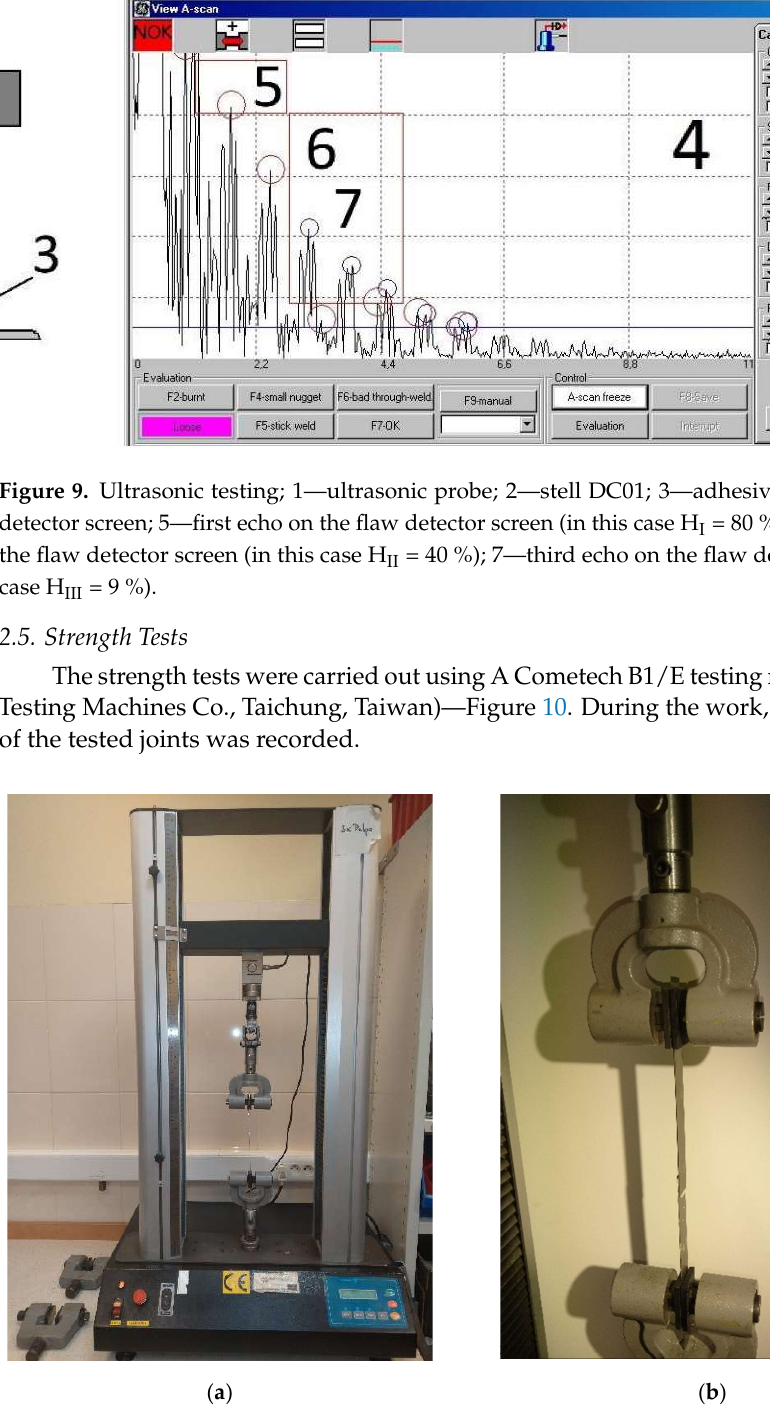
Figure 10. Testing machine; ( a ) general view, ( b ) specimen clamped.